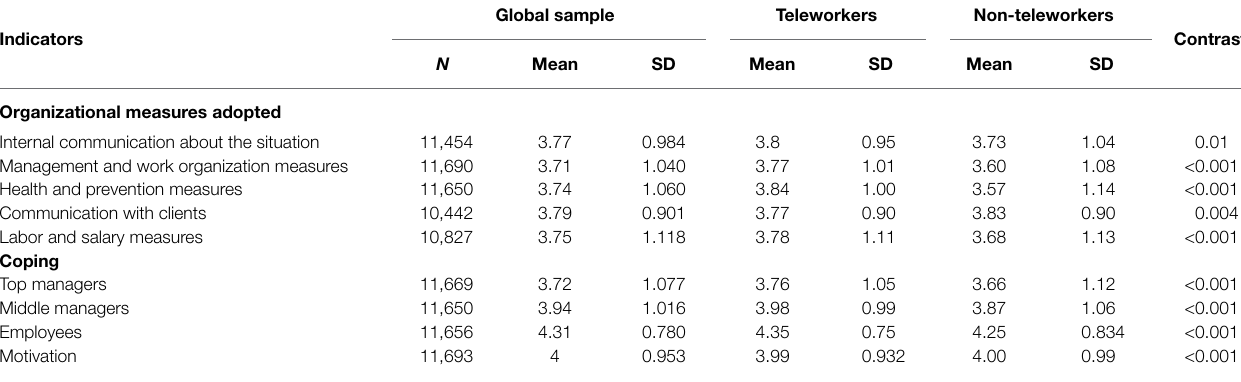
TABLE 3 | Descriptive statistics and comparisons between teleworkers and non-teleworkers.